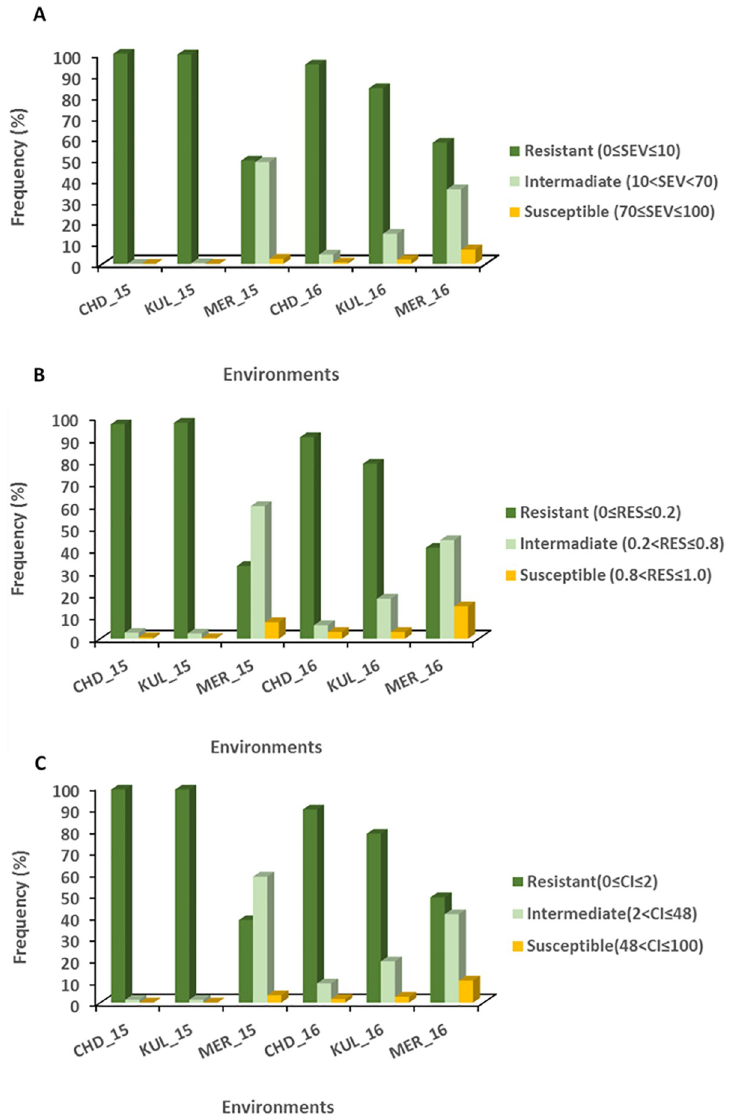
Fig 1. Reaction to yellow rust of 293 Ethiopian durum wheat accessions obtained from field experiments in six environments. A) severity, B) Field Response and C) Coefficient of Infection. The reaction data of severity and field response was used to classify the panel in to Resistant, Intermediate and Susceptible groups as described in Liu et al. [17] and taking the corresponding values for Coefficient of Infection as well.